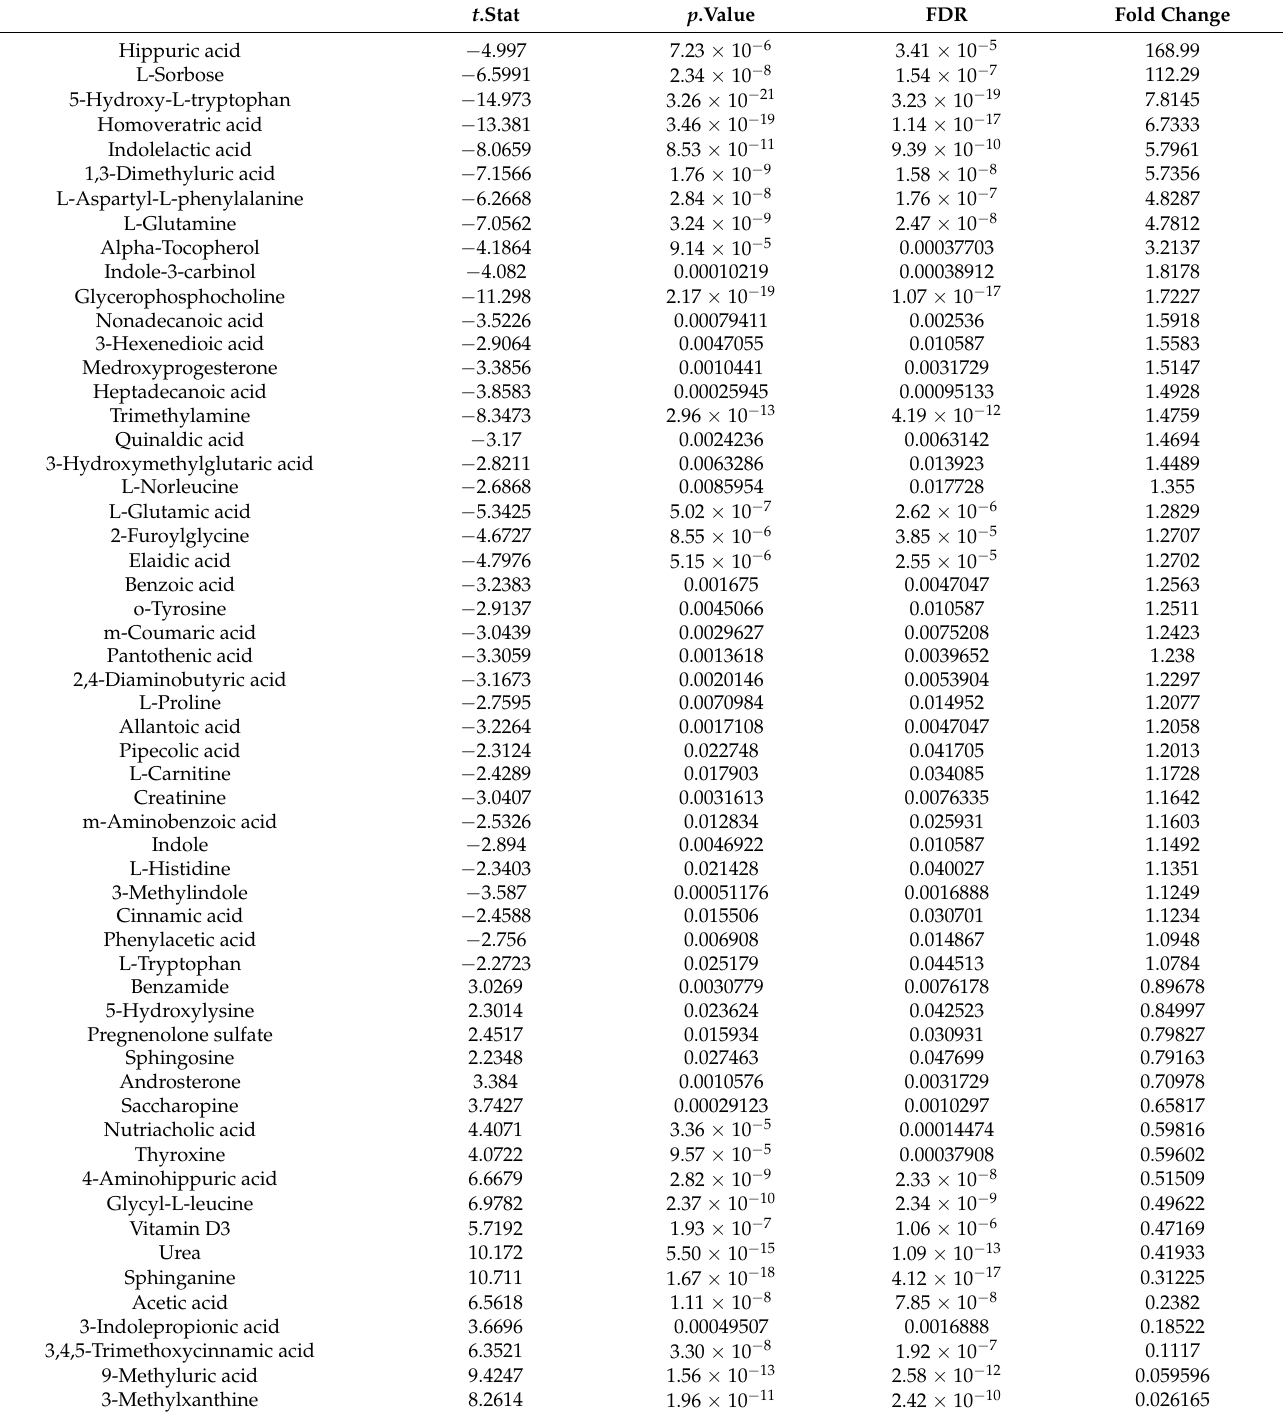
Table 3. Statically significant metabolites among the prediabetic MetS group and the controls. t